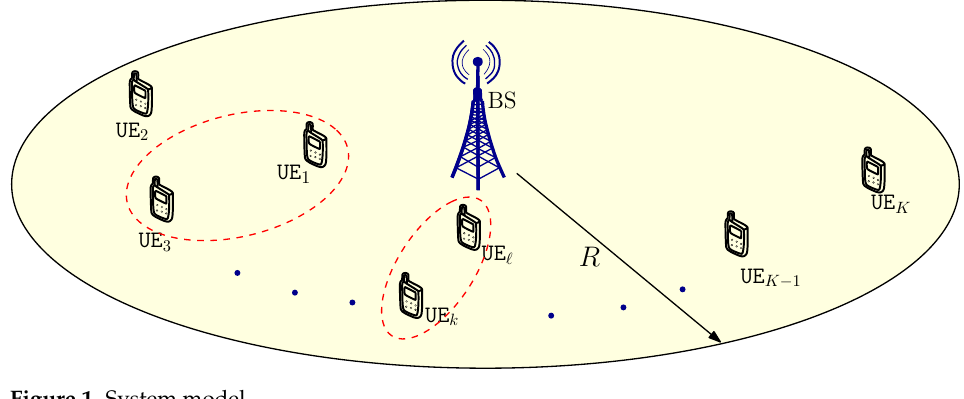
Figure 1. System